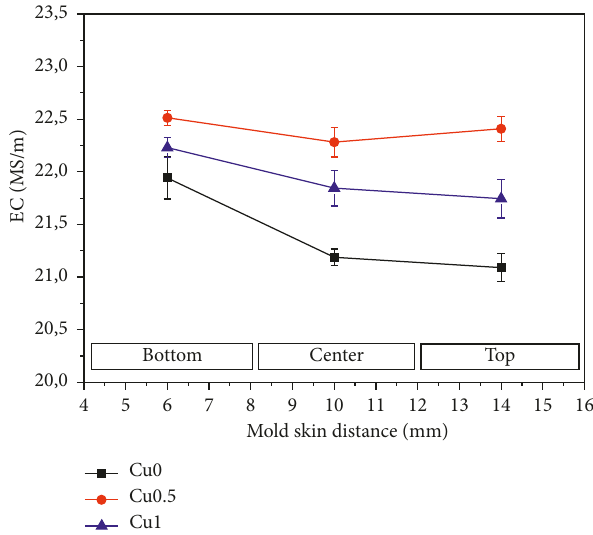
Figure 8: Cu0, Cu0.5, and Cu1 electrical conductivity measure- ments over the three investigate positions: bottom, center, and Figure 7(a). The rounded eutectic phases, indicated as Al-Q- θ (Figures 7(b) and 7(c)), together with both the eutectic and